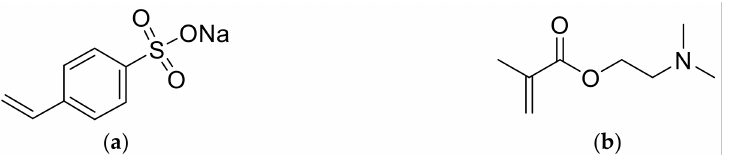
Figure 1. Chemical structure of ( a ) NaSS anionic monomer and ( b ) DMAEMA cationic monomer. Initially, a seed with MMA/BA (50/50 wt%) at 10% s.c. for anionically charged system